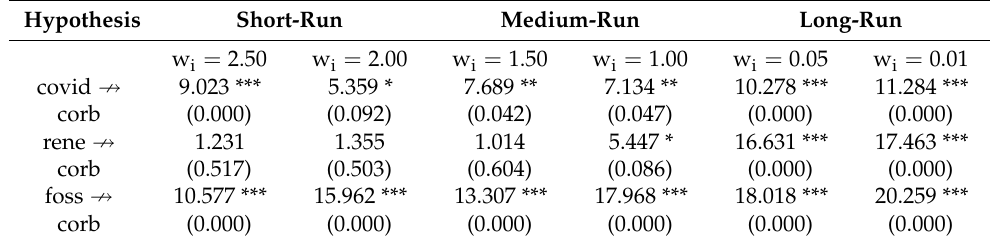
Table 6. Results of frequency domain causality